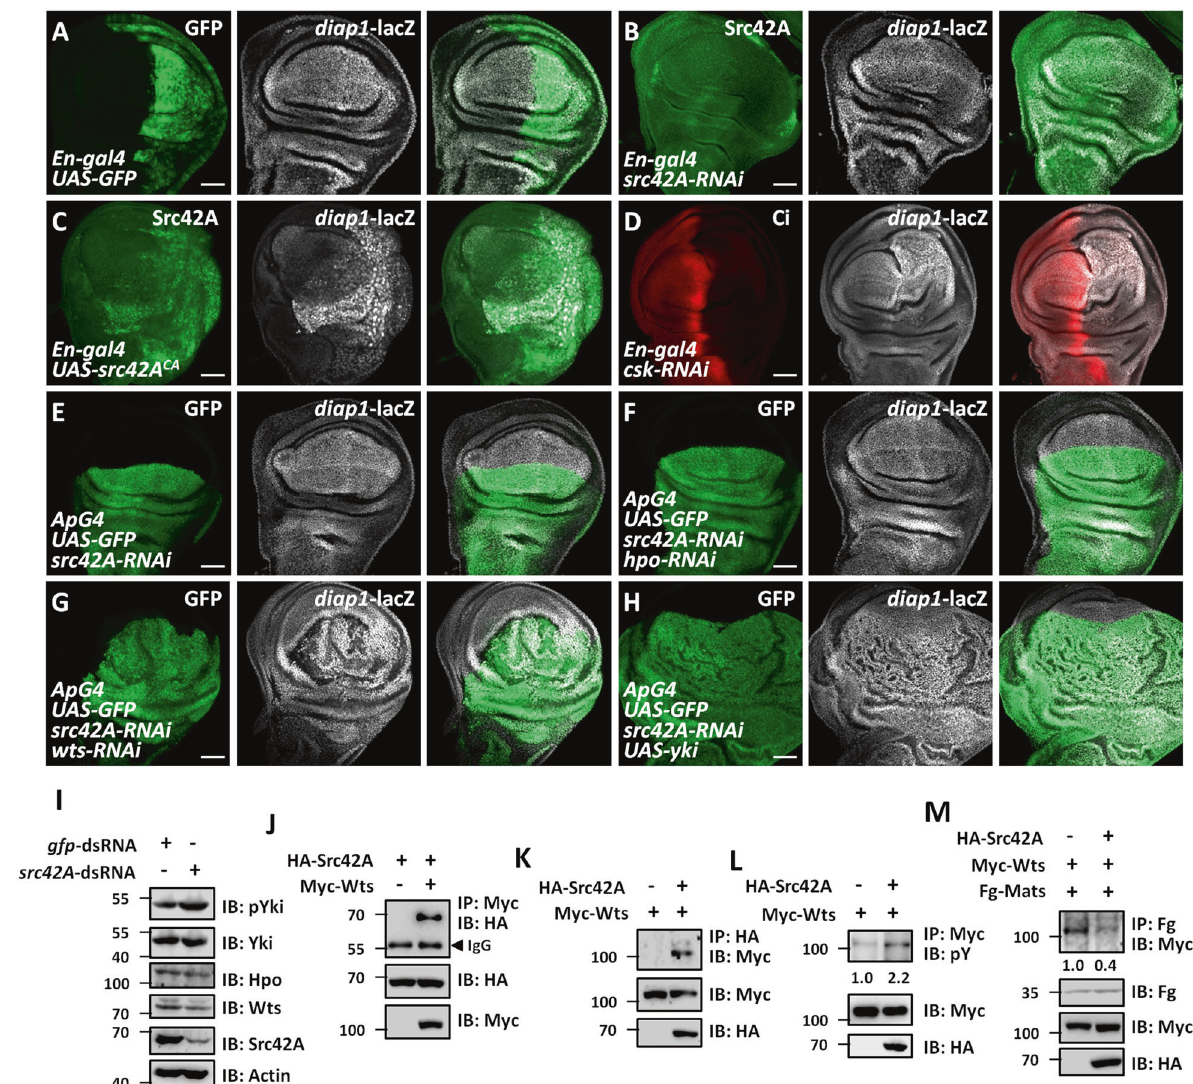
Fig. 5 Src42A suppresses the Hippo pathway activity. A A control wing disc was stained to show GFP (green) and diap1 -lacZ (white). En-gal4 drives gene expression in the posterior region of the wing disc. B A wing disc expressing src42A RNAi by En-gal4 was stained to show Src42A (green) and diap1 -lacZ (white). Of note, knockdown of src42A decreased diap1 -lacZ. C Overexpression of a constitutive active form of Src42A (Src42A CA ) elevated diap1 -lacZ in the wing disc. D Knockdown of csk in the wing disc activated diap1 -lacZ expression. E A control wing disc expressing src42A RNAi by ApG4 was stained to show GFP (green) and diap1 -lacZ (white). ApG4 exclusively expresses in the dorsal region of wing disc. F Knockdown of hpo failed to restore the decreased diap1 -lacZ caused by src42A RNAi. G Silence of wts upregulated diap1 -lacZ under src42A RNAi background. H Ectopic expression of yki rescued src42A -RNAi-induced diap1 -lacZ decrease. I Knockdown of src42A increased pYki level in S2 cells. Actin serves as a loading control. J Myc-Wts pulled down HA-Src42A in S2 cells. K HA-Src42A pulled down Myc-Wts in S2 cells. L Src42A promoted tyrosine phosphorylation of Wts in S2 cells. M Src42A decreased the af fi nity between Wts and Mats in S2 cells. Scale bars: 50 μ m for all images. All western blot assays were repeated three times. The numbers on L and 0y9t 660 7p ik>.'p represented the relative intensities of the Oncomine database (https://www.oncomine.org) and found Wts/LATS1 is conserved from Drosophila to that both YAP and SRC were highly expressed in HCC tissues mammalian cells. compared with normal liver tissues (Fig. 6A, B) [51]. A co- expression analysis using protein atlas data (https://www. SRC is a target of YAP and is critical for YAP-induced tumor proteinatlas.org) showed that SRC mRNA levels positively corre- cell migration lated with YAP mRNA in HCC samples (Fig. 6C). To validate these Having shown that the Yki-Src42A module promotes tumor cell bioinformatic results, we carried out RT-qPCR experiments and migration in Drosophila , we then tested whether a similar found that both YAP and SRC were indeed upregulated in HCC mechanism operates in human tumor cells. We chose human samples compared to the adjacent normal tissues (Fig. 6D). hepatocellular carcinoma (HCC) because our previous study has To test whether SRC is a target of YAP in HCC cells, we fi rst revealed that YAP protein is upregulated in HCC samples and analyzed protein levels of SRC and YAP in six HCC cell lines. Both closely linked to tumor progression [50]. To assess the expression RT-qPCR and western blot results revealed that SRC positively of YAP and SRC in HCC, we fi rst analyzed the microarray data from